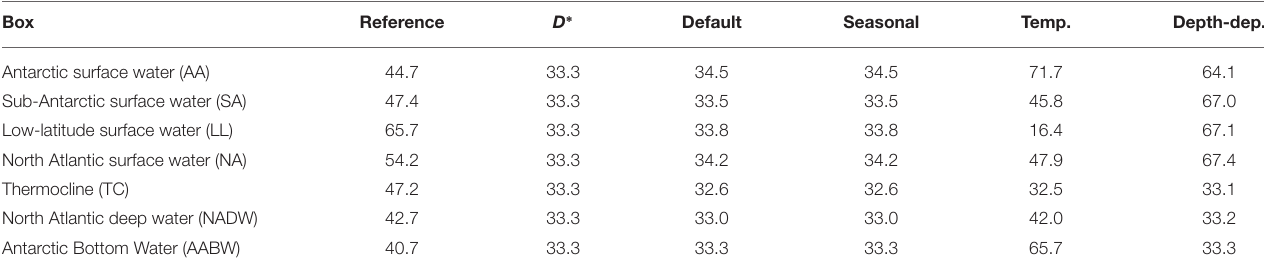
TABLE 3 | DOC concentration from reference data, the equilibrium prediction by the biogeochemical model ( D ∗ ), and from four box model simulations: the default set-up, a model modification with seasonal supply, a model modification with temperature-dependent uptake rate, and a model modification with depth-dependent physiological parameters.